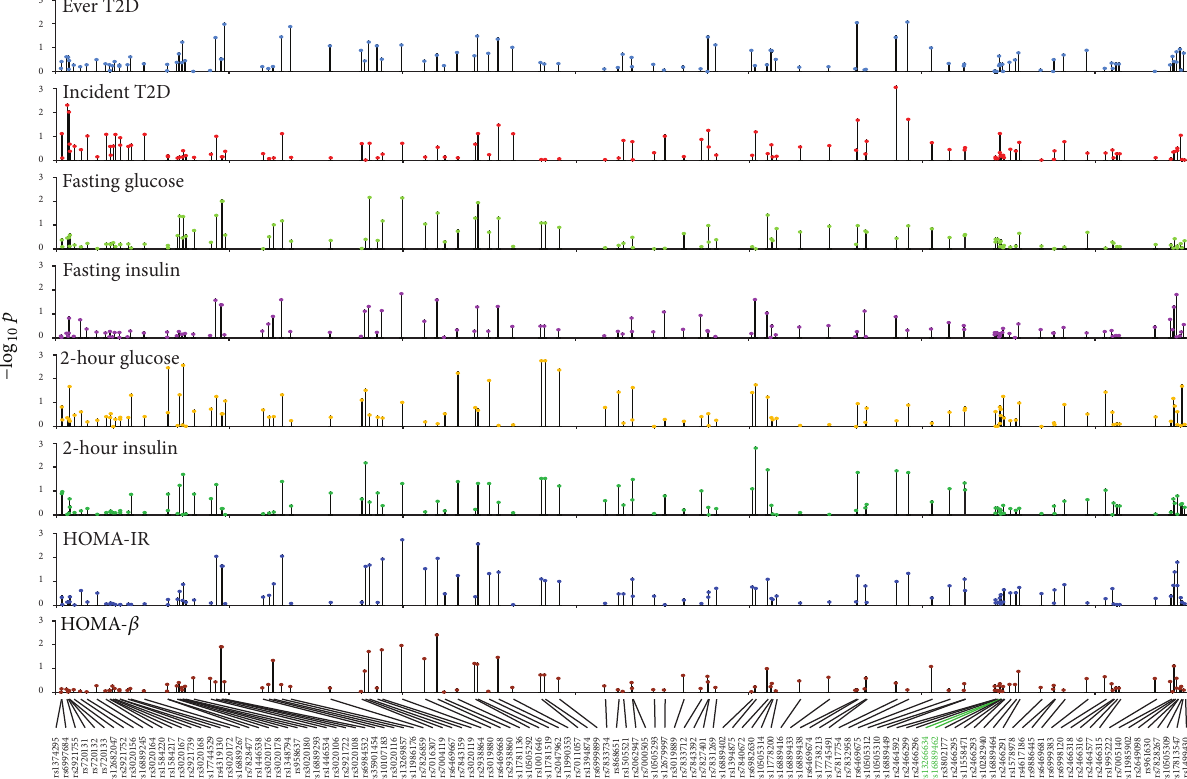
Figure 1: Association of 118 SNPs within and around SLC30A8 with T2D-related traits. Abscissa shows the names and locations of the SNPs on chromosome 8 and the ordinate shows statistical significance. After correcting for 49 independent tests, we need a − log 10 𝑝 value of 2.99 for statistical significance at a global type I error rate of 0.05 for each trait. Full quantitative results are provided in Supplementary Table 1. Coding variants are indicated in green.